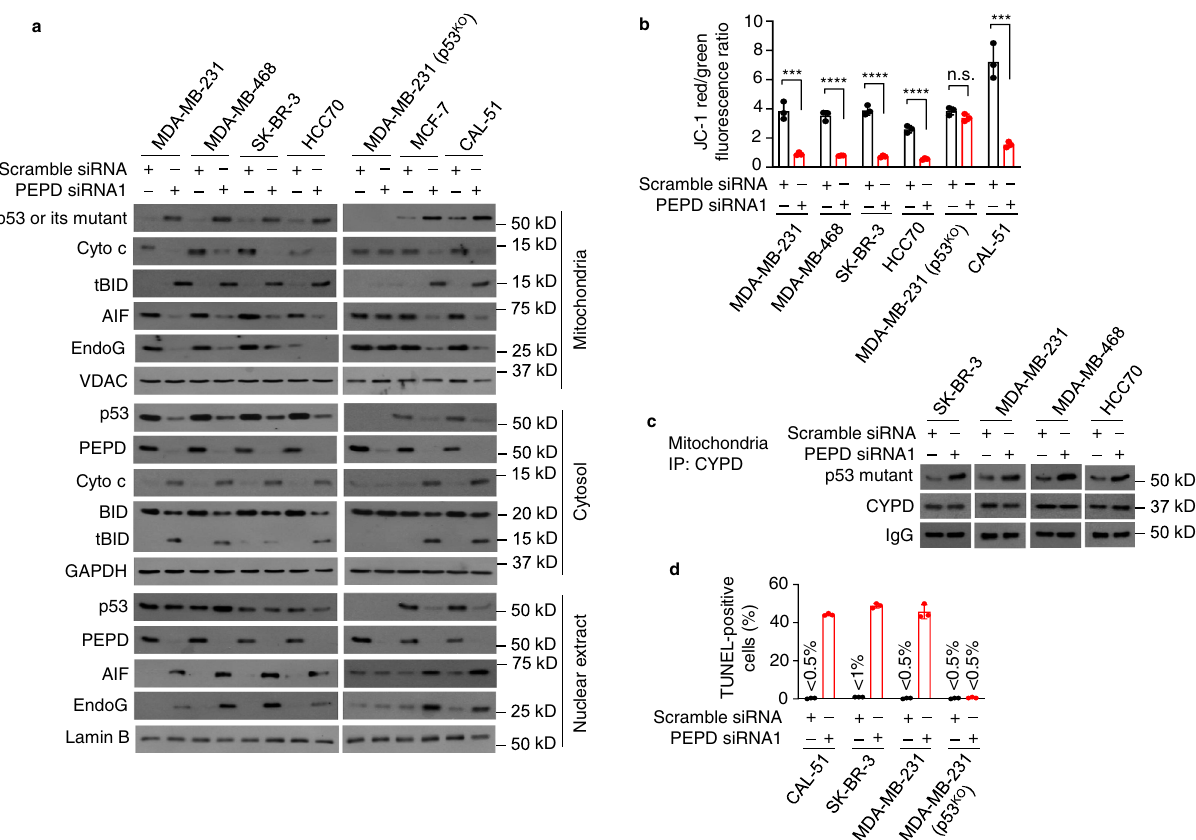
Fig. 5 PEPD KD reactivates the transcription-independent tumor suppressor activities of p53 mutants. a Cells were treated by siRNA (10 nM) for 48 h. p53, p53 mutants and other proteins in subcellular fractions were analyzed by WB, using voltage-dependent anion channel (VDAC), GAPDH and lamin B as loading controls. b Cells were treated by siRNA (10 nM) for 48 h. MMP was measured by JC-1 fl uorescence. c Cells were treated by siRNA (10 nM) for 48 h, from which mitochondria were isolated and analyzed by IP-WB for CYPD binding to p53 mutants. d Cells were treated by siRNA (10 nM) for 72 h. Apoptosis was measured by TUNEL assay, counting 500 cells per sample (see also Supplementary Fig. 5). The bar-dot plots in b and d show individual values and mean ± SD ( n = 3). **** P < 0.0001, by paired two-tailed t -test in b . Cells carrying p53 (MCF-7 cells and CAL-51 cells) or MDA-MB-231 (p53 KO ) cells were included in a, b , and d for